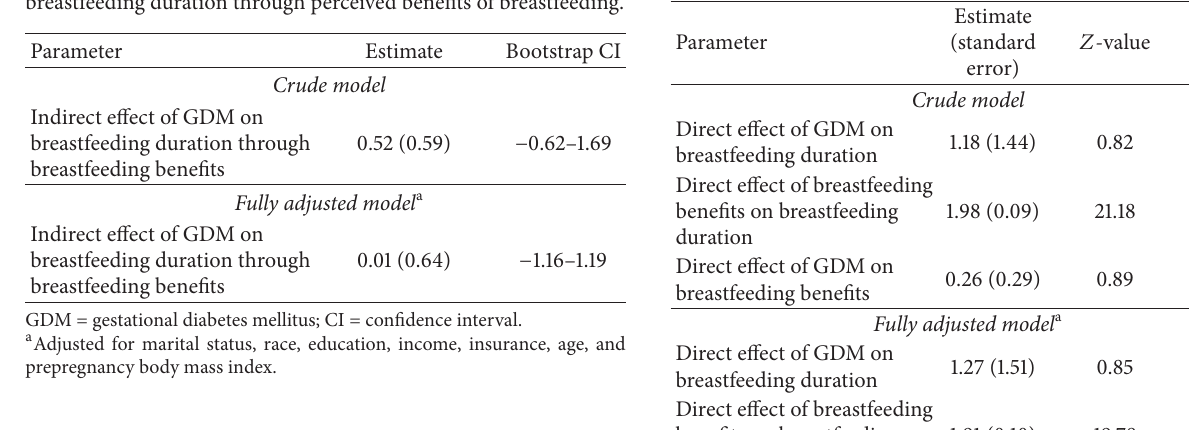
Table 3: Parameter estimates of direct